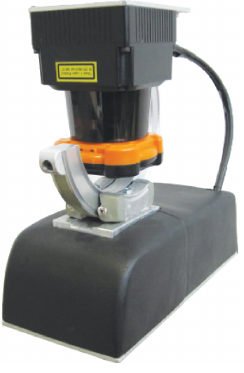
Figure 5. The UNOlaser rangefinder.